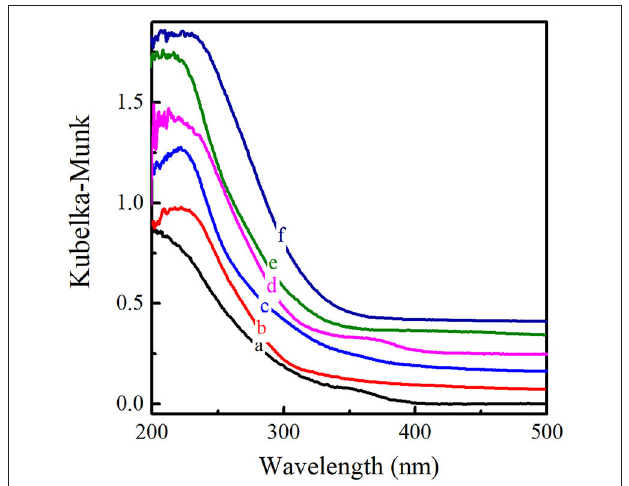
FIGURE 1 | UV-visible diffuse reflectance spectra of Ti-MWW (a), Ti-Beta (b), Ti-MOR (c), Ti-MCM-68 (d), TS-1 (e), and TS-2